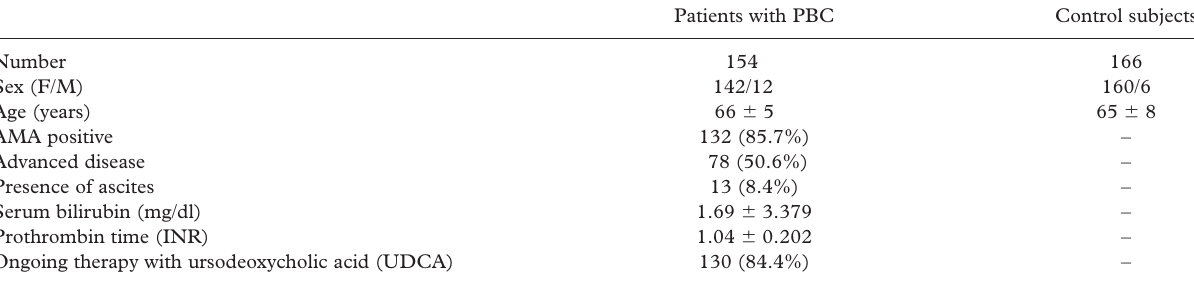
Table II. Demographic and clinical features of patients with PBC and controls enrolled in this